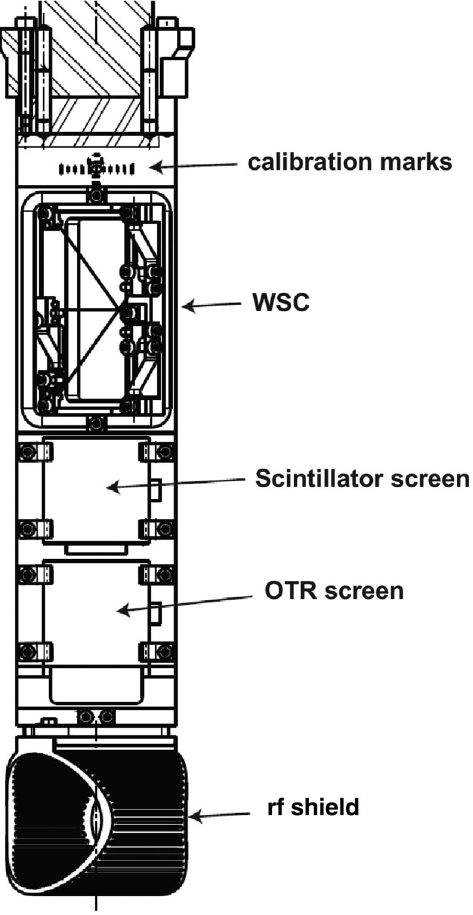
FIG. 5. Technical drawing of the SITF view-screen holder with the integrated WSC extension.